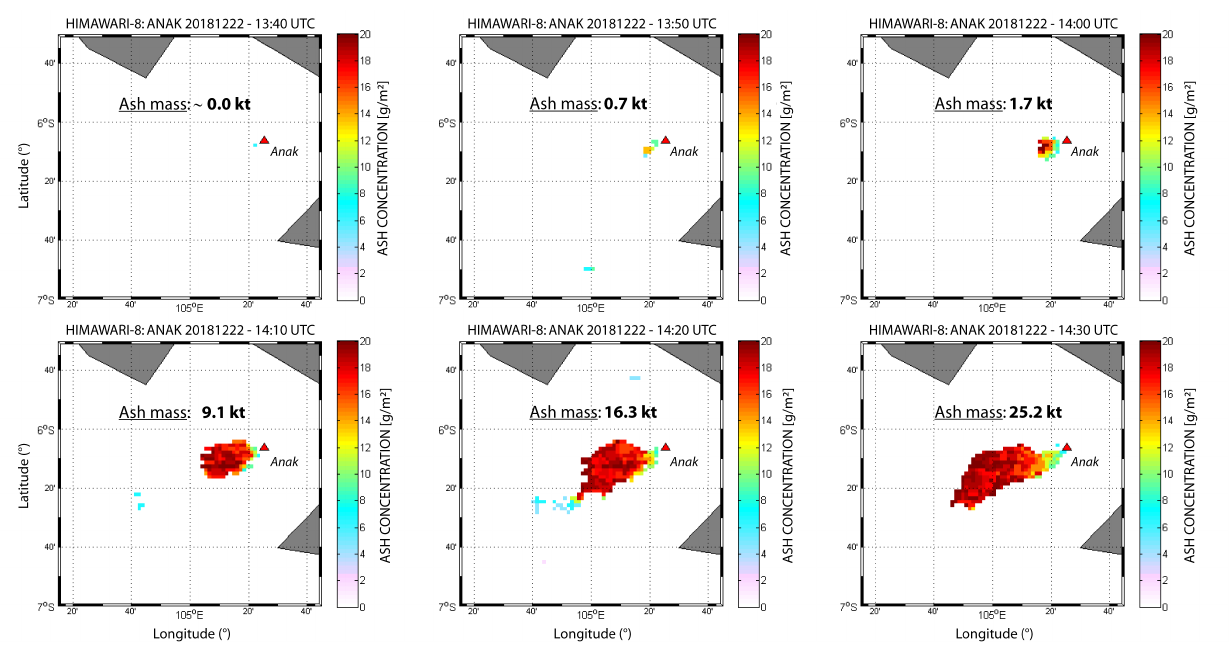
Figure 6: Airborne ash mass concentration (in gm − 2 ) retrieved from inversion of thermal infrared images using Himawari-8 data. These images show (i) the onset of the eruption at 13:50 UTC, i.e. synchronous with the collapse, (ii) the ash plume direction at a 10-minutes time resolution and (iii) the increase of the total ash mass loading.